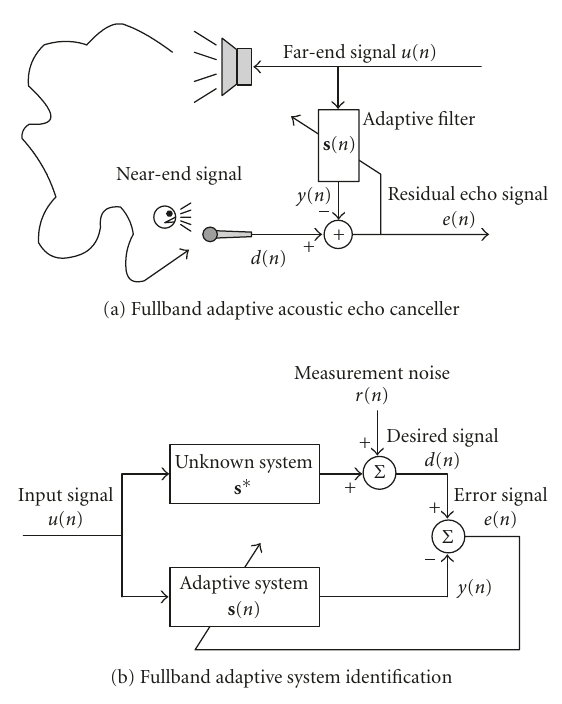
Figure 1: Fullband system identification for adaptive acoustic echo